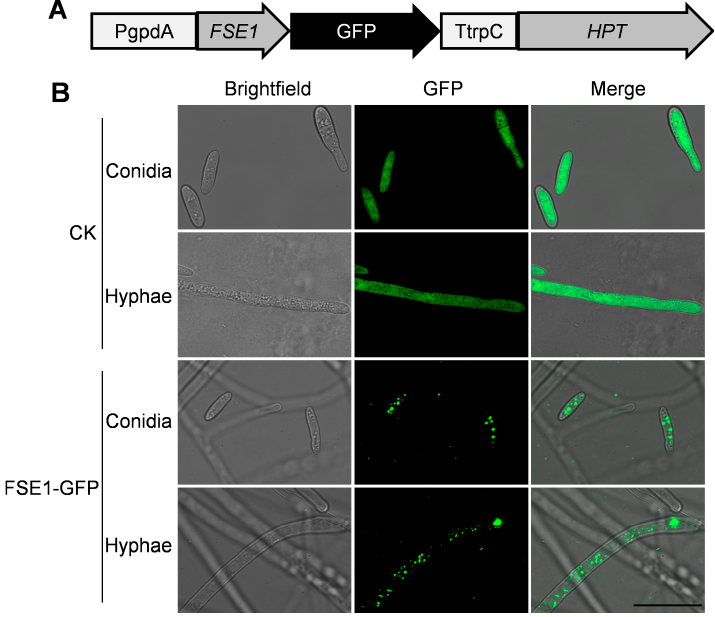
Figure 4. FSE1-GFP is distributed in vesicles of Foc TR4. ( A ) Expression cassette of FSE1-GFP. ( B ) Fluorescence microscopes of conidia and hyphae of Foc strains. Scale Bar = 20 μ m.